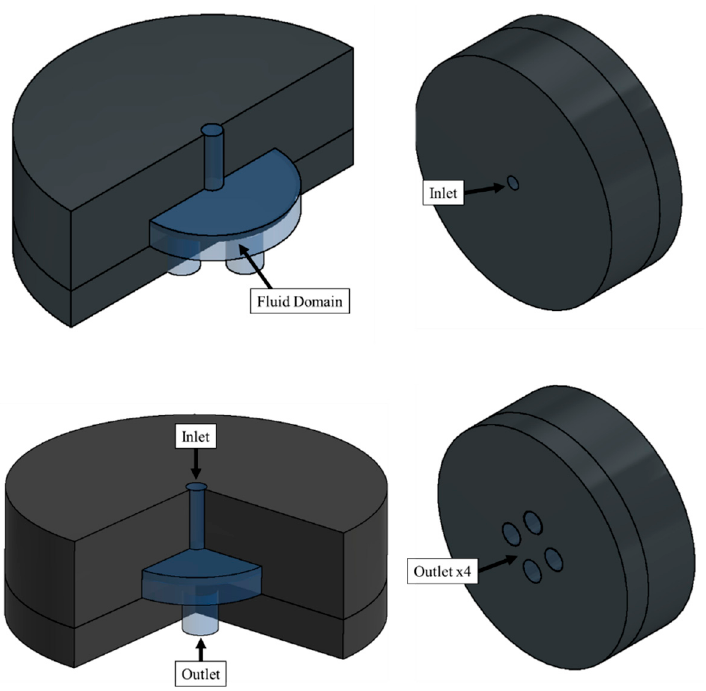
Figure 9. Computational domain generated from the internal fluid and boundary conditions for the validation.